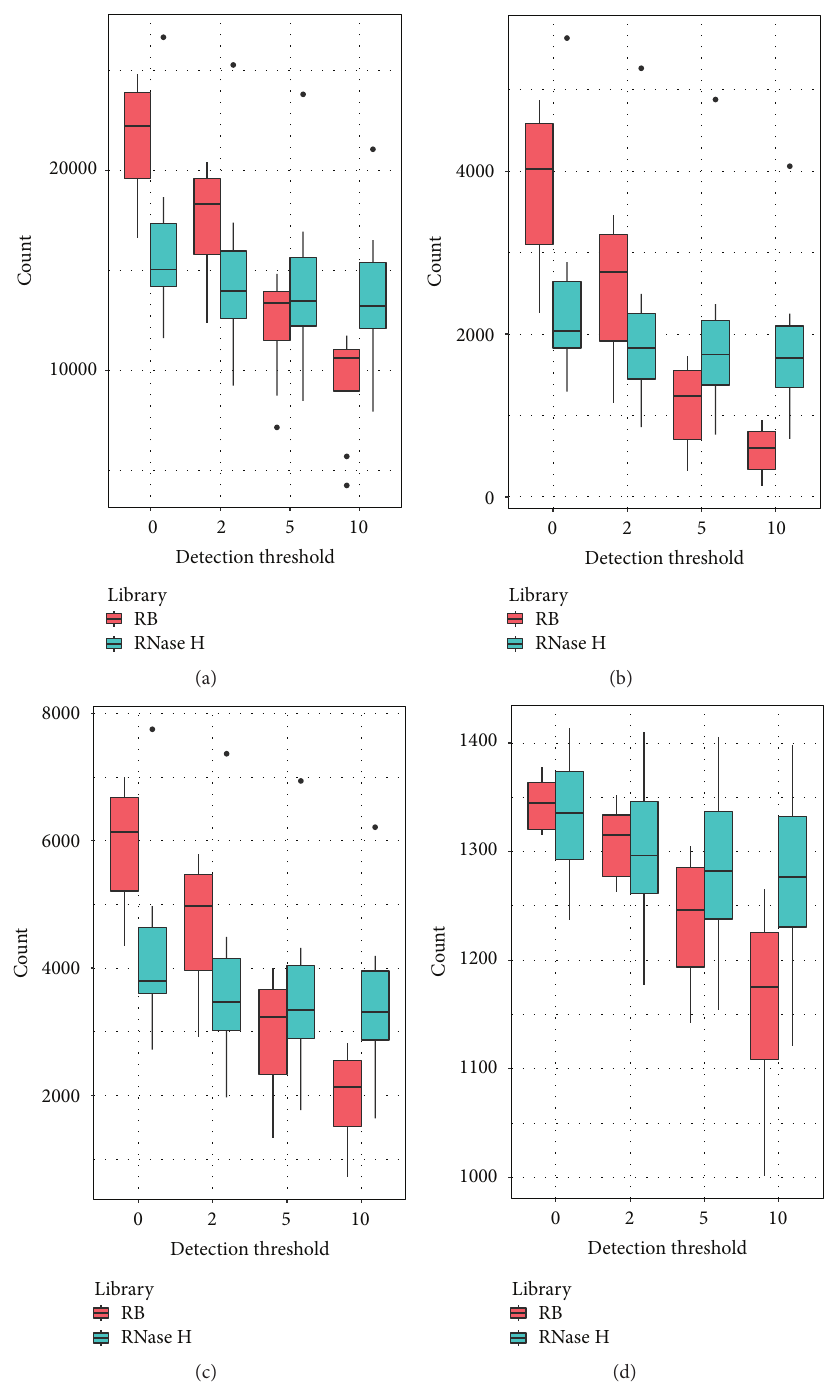
Figure 4: Detected RNA using thresholds: normalized reads count > 0, 2, 5, and 10. (a) Protein coding RNA. (b) lncRNA. (c) Enhancer RNA. (d) Super enhancer RNA. At lower thresholds (more noise), Ribo-Zero samples detected more RNAs. At higher thresholds (more reliability), RNase H method detected more